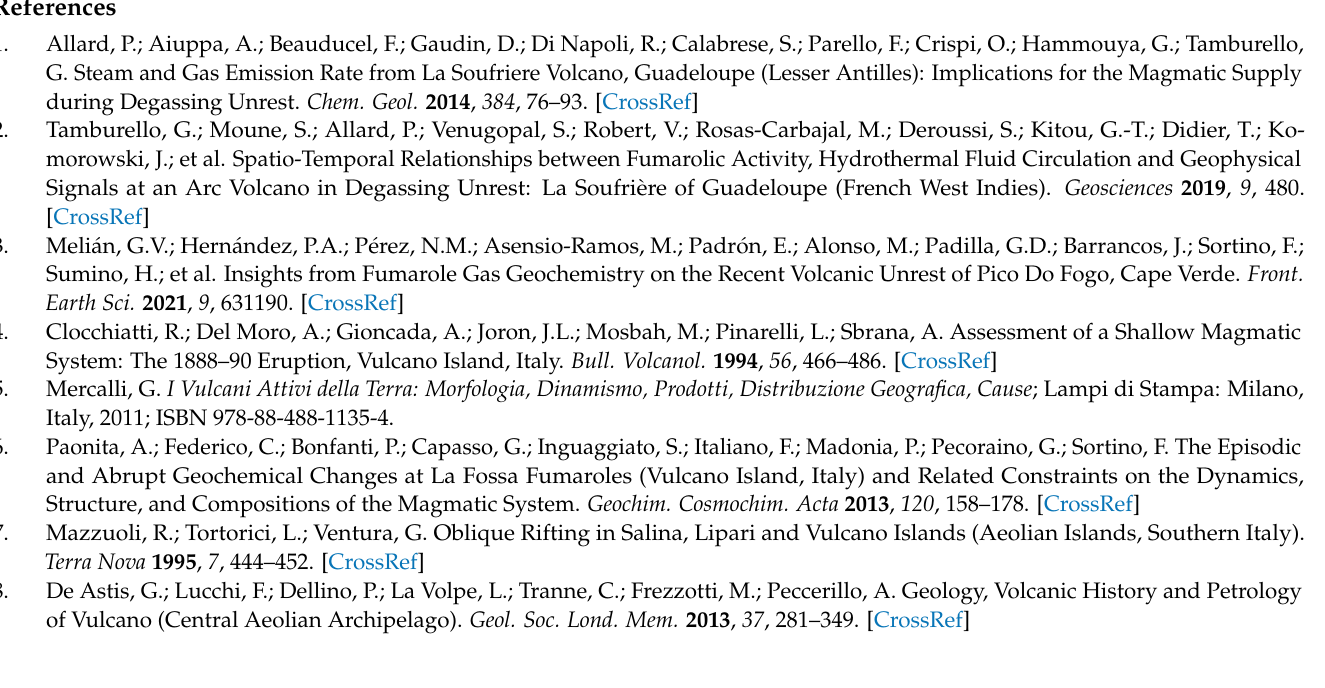
Table S10: Tilt; Table S11: Gravimetric